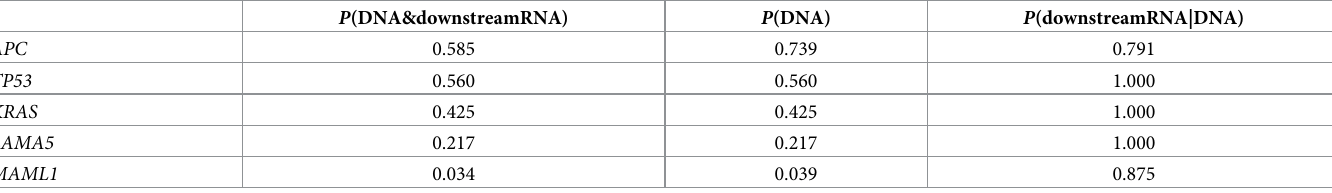
Table 3. Colon core source genes. There are five “core” source genes which appear in every minimal source covering of the colon samples. P (DNA) is the fraction of sam- ples for which the indicated source gene is DNA-aberrant; P (DNA&downstreamRNA) is the fraction of samples for which the indicated source gene is DNA-aberrant and there exists an RNA-aberrant gene among its targets. P (downstreamRNA|DNA) is the fraction of the samples with the indicated source gene DNA-aberrant for which there exists some RNA-aberrant gene among its targets.